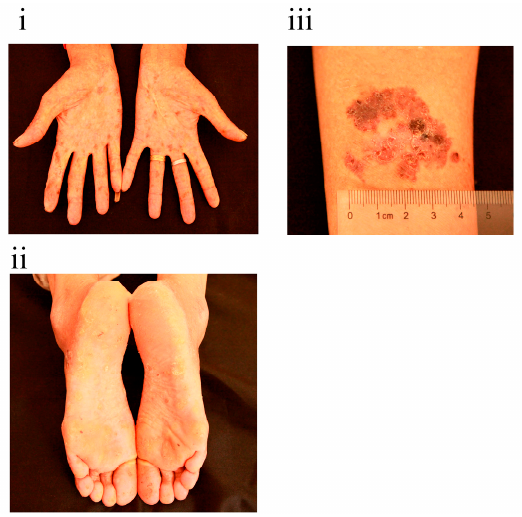
Figure 1. Clinical appearance of the woman we first identified: ( i ) palms; ( ii ) soles; ( iii ) right arm.